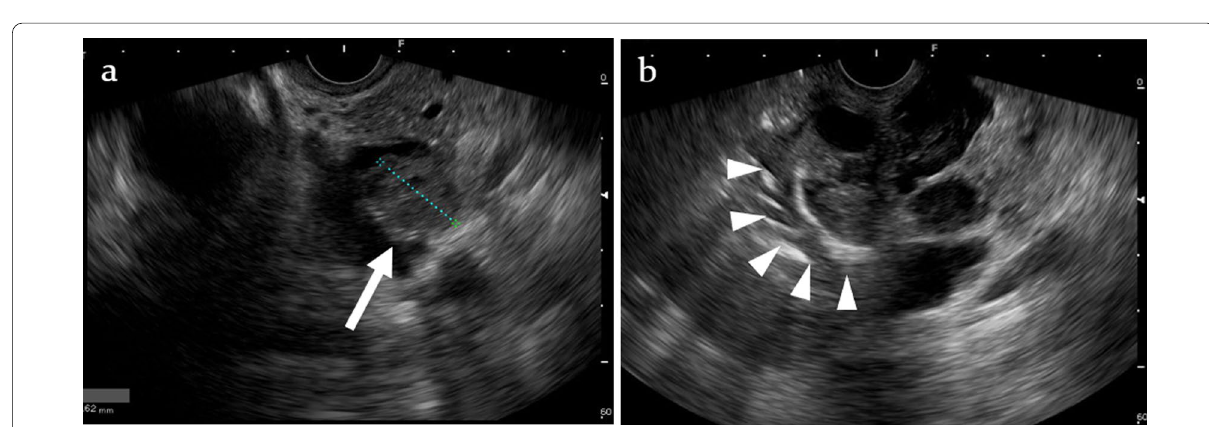
Fig. 3 a Endoscopic ultrasound (EUS) revealed a multilobular cystic lesion with a 17 mm mural nodule (white arrow) in the pancreatic head. The blood flow signal in the mural nodule was not observed. b Prominent calcification with acoustic shadow was observed on part of the cyst wall (white